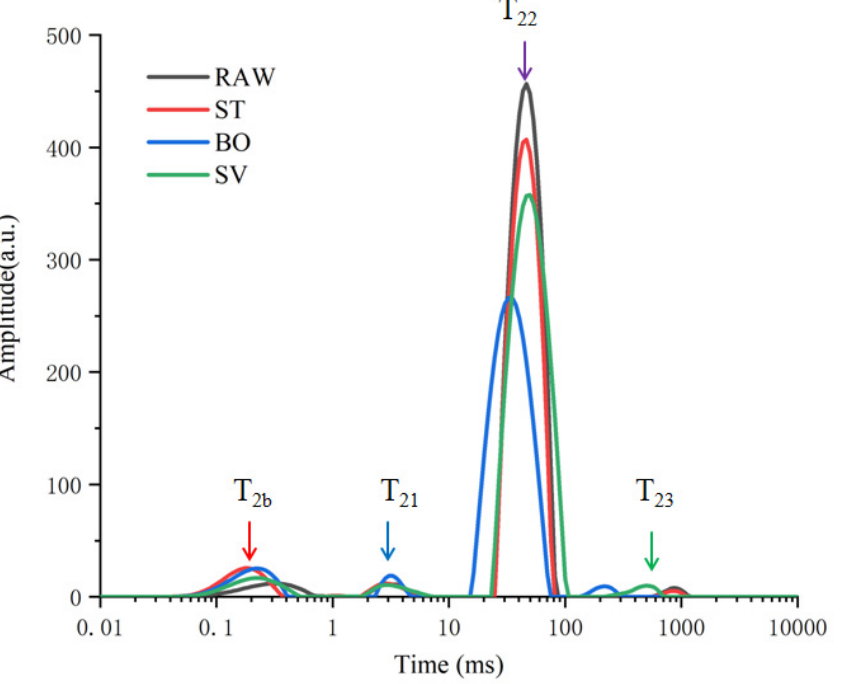
Figure 1. T 2 relaxation time distribution curves of squid ( Symplectoteuthis oualaniensis ) mantle muscle samples before and after treatment of RAW, ST, BO, and SV. RAW: raw squid; ST: steaming; BO: boiling; SV: sous vide.